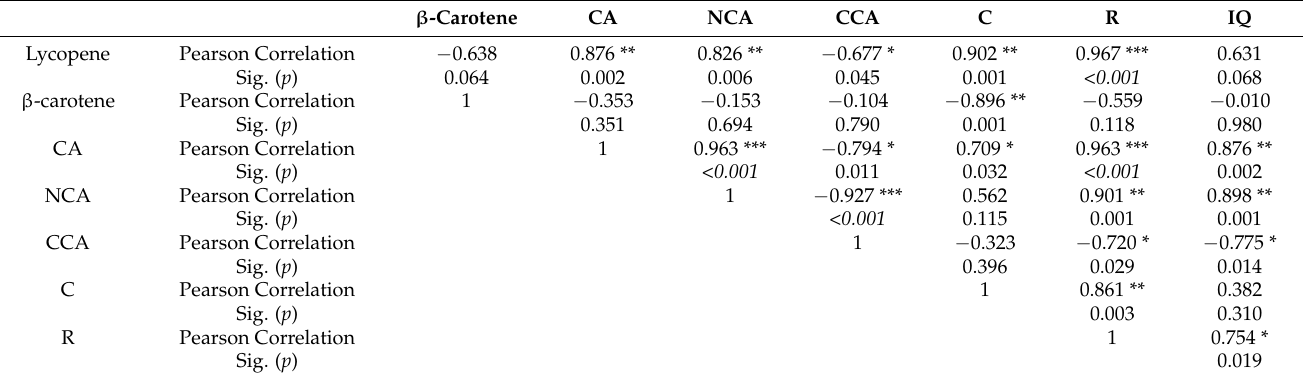
Table 6. Correlation matrix of honeyberry lycopene, β -carotene, chlorogenic (CA), neochlorogenic acids (NCA), cryptochlorogenic (CCA), catechin (C), rutin (R), and isoquercetin (IQ) contents. β -Carotene CA NCA CCA IQ